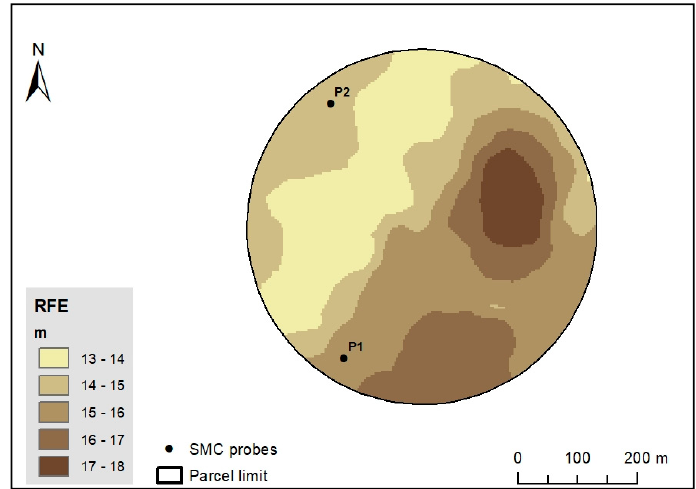
Figure 6. Altimetric map of the “Eucalyptus” field. P1 and P2 are soil moisture content (SMC) probes.